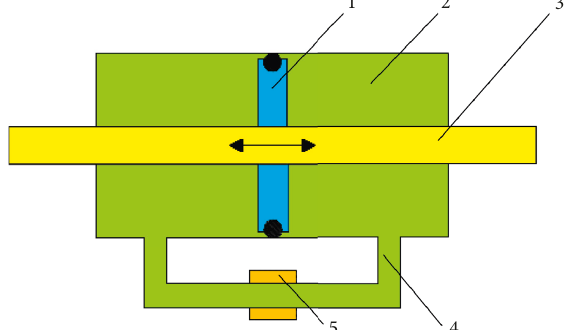
Figure 18: Schematic of bypass-type MR damper: 1, piston; 2, MRF; 3, shaft; 4, bypass duct; 5, coil [33].